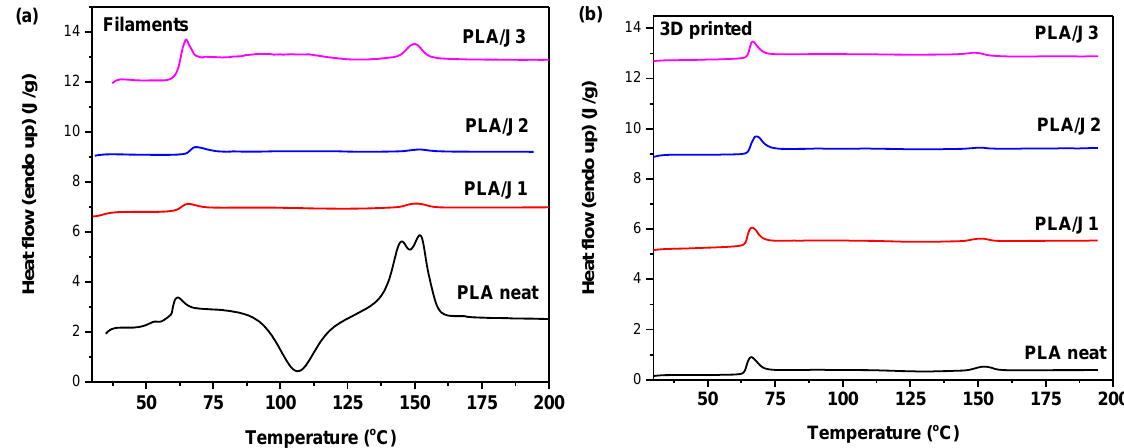
Figure 2. DSC traces of the ( a ) PLA filaments and the ( b ) PLA 3D-printed specimens during heating at 20 °C/min. Table 2. DSC results of the PLA filaments and 3D-printed constructs.